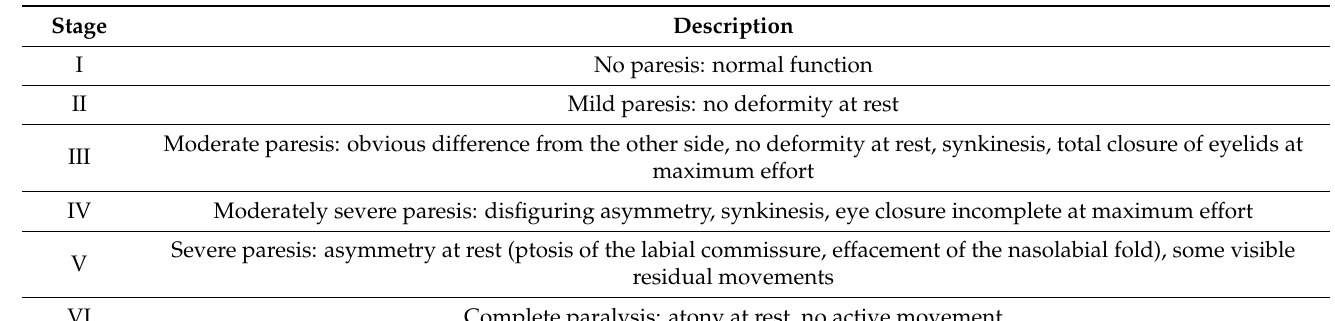
Table 3. House-Brackmann facial nerve grading